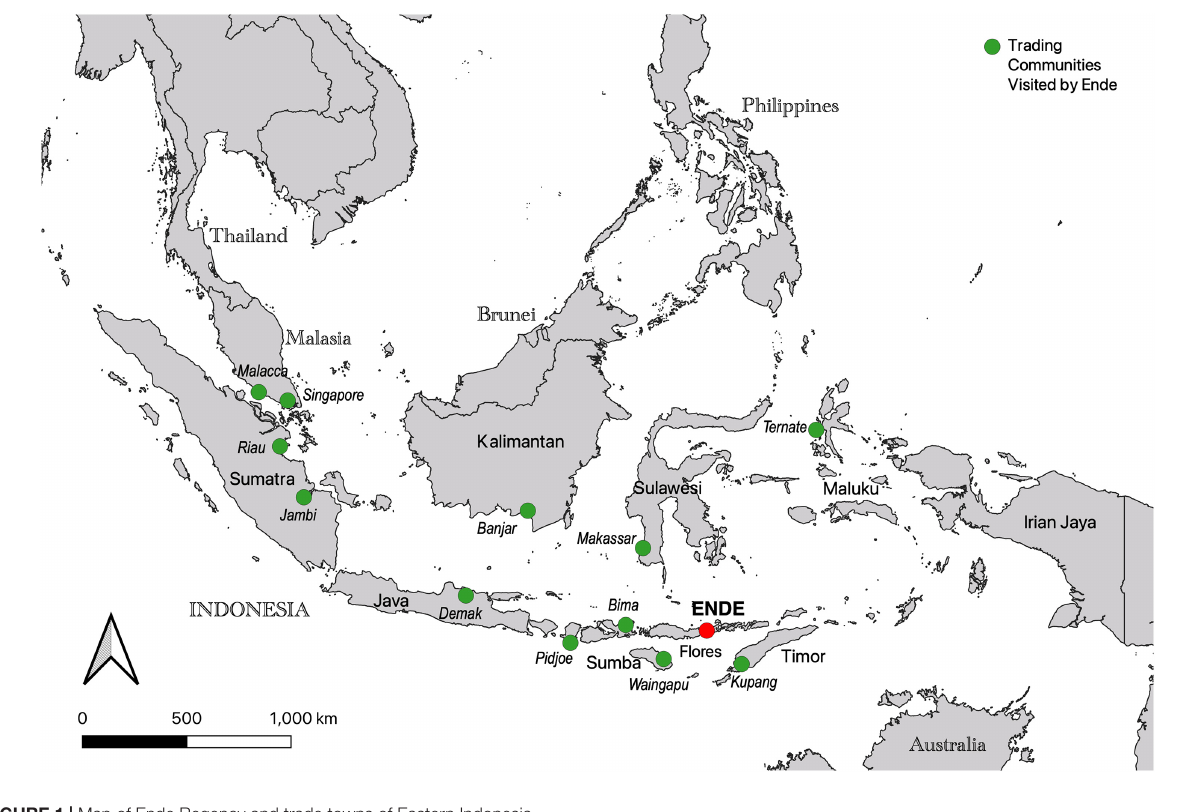
FIGURE 1 | Map of Ende Regency and trade towns of Eastern Indonesia.